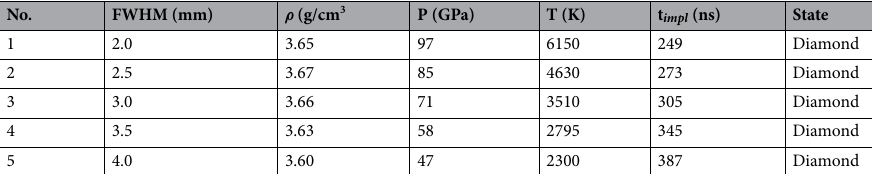
Table 6. Achieved physical conditions in compressed carbon using bunch intensity = 2 × 10 11 uranium ions, bunch length = 200 ns, particle energy = 2 GeV/u, initial sample radius, R si = 400 μm, sample mass = 11.3 mg/ cm.